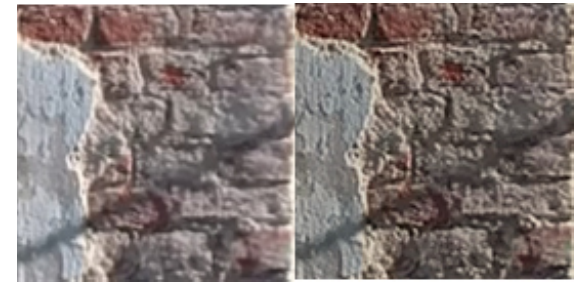
Figure 7. Detail of the façade degradation (highlighted in green in the Figure 5) for the Orthophoto generated with Pix4D (left) and MicMac (right).